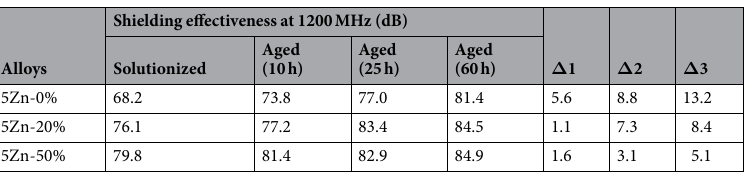
Table 2. EMI shielding effectiveness of Mg-5Zn alloy in various states. * Δ 1 = aged (10 h)–solutionized, Δ 2 = aged (25 h)–solutionized, Δ 3 = aged (60